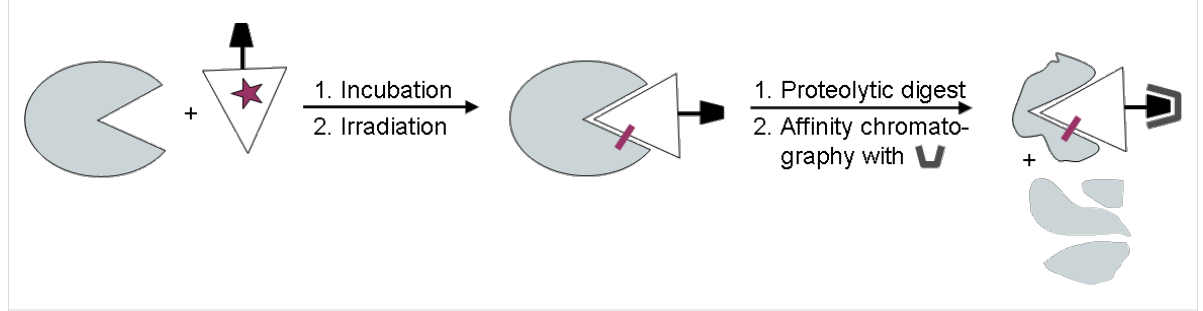
Figure 1: The photoaffinity technique allows the identification of ligand binding sites of a receptor protein after photo-crosslinking, proteolysis and affinity chromatography.